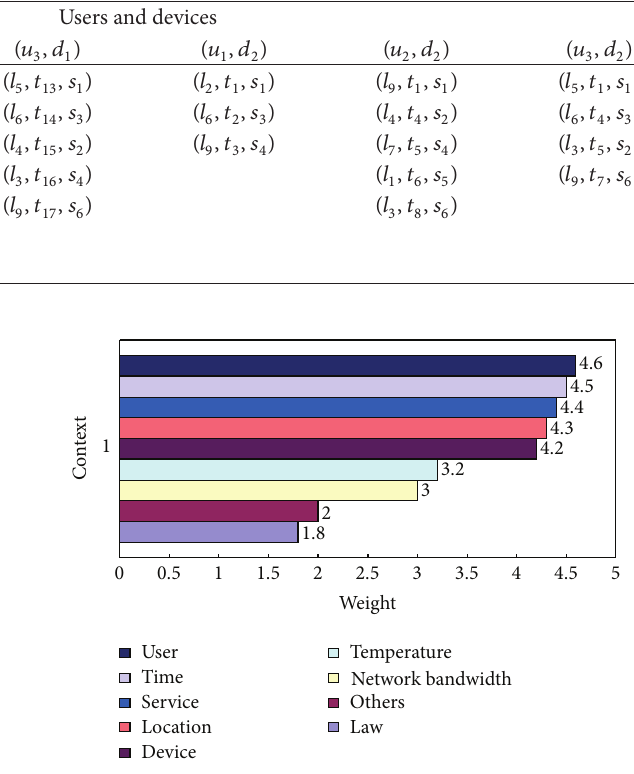
Figure 3: The results of the